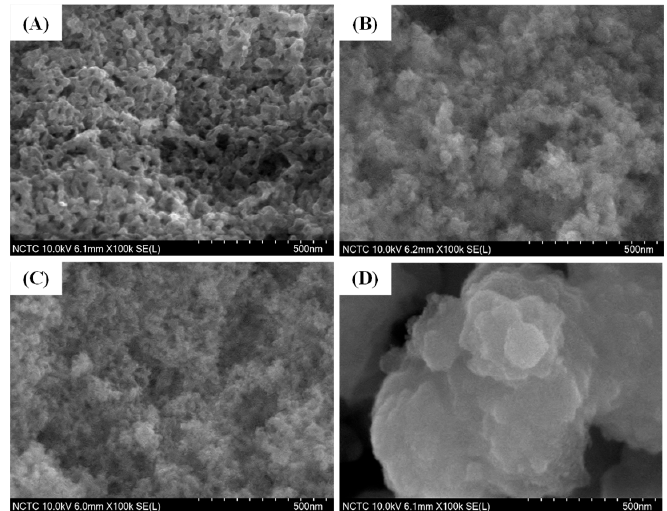
Figure 6. FE-SEM images of ( A ) WMS, ( B ) WMS-0.10, ( C ) NR/WMS and ( D ) NR/WMS-0.10 at magnification of 100,000 × .